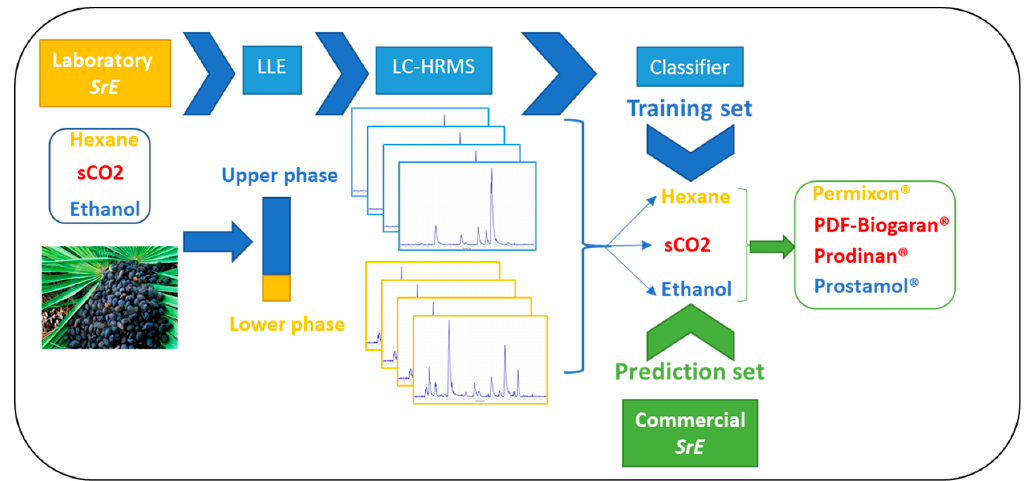
Figure 1. The workflow chart of liquid chromatography-mass spectrometry (LC-MS)-based metabolomic approach: Laboratory and commercial SrE were submitted to a liquid-liquid extraction (LLE) prior to LC-HRMS profiling. A statistical model was set up using laboratory SrE as a training